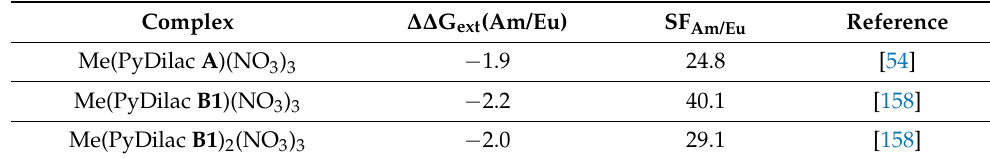
Table 2. The Gibbs energies of formation of complexes and Am-Eu separation factors, based on [53,158]. Me stands for Am or